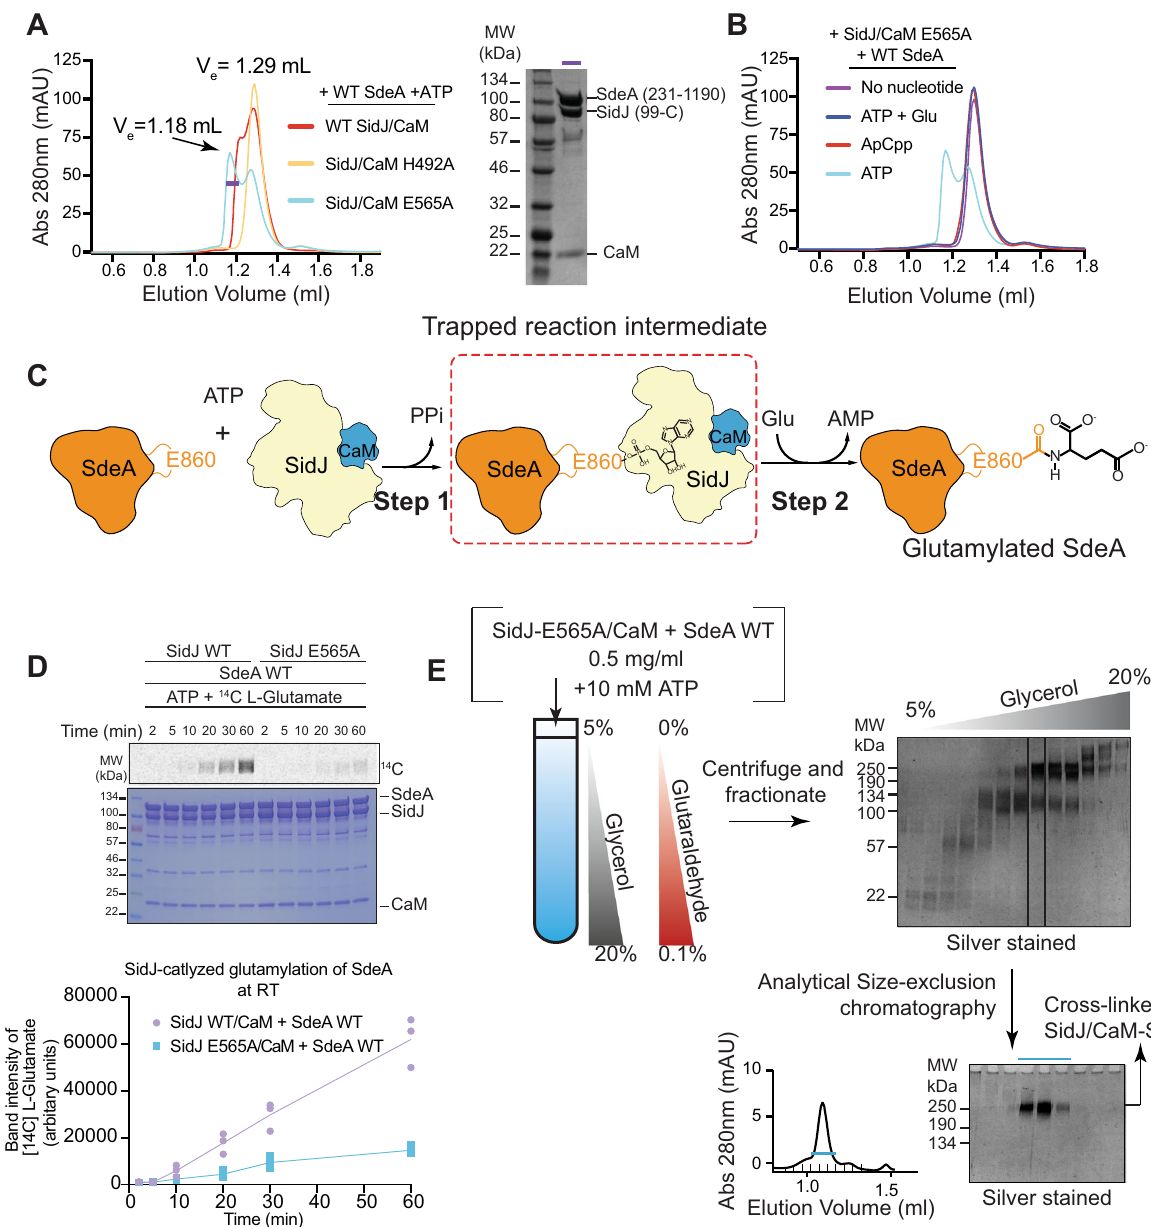
Fig. 1 SidJ E565A/CaM and SdeA form a stable reaction intermediate complex. A Size-exclusion chromatography (SEC) pro fi les of SidJ/CaM and SdeA in the presence of ATP. The highlighted fraction in the SidJ/CaM E565A + SdeA sample is shown on SDS-PAGE (right). B SEC pro fi les of SidJ/CaM E565A + SdeA in the presence of various cofactors. C Schematic representation of the reaction scheme of SidJ-mediate glutamylation of SdeA highlighting the trapped adenylylated reaction intermediate between SidJ/CaM and SdeA. D Time course experiment measuring the incorporation of [ 14 C]-Glu into SdeA catalyzed by SidJ using SidJ WT, SidJ E565A. Samples were separated by SDS-PAGE and visualized by Coomassie stain and autoradiography (Top). The experiment was done in triplicates and [ 14 C]-bands were quanti fi ed and plotted (Bottom). Purple corresponds to WT, blue corresponds to the E565A mutant. Individual measurements are shown. E Flow chart of the sample preparation process of SidJ E565A/CaM + SdeA for Cryo-EM. From left to right, samples are incubated and then cross-linked via GraFix method. Fractions are analyzed via SDS-PAGE and further puri fi ed via SEC. AMP moiety (Fig. 1C). Subsequently, the amino group of a free L - performed at 37 °C. Our time course glutamylation experiment glutamic acid molecule launches a SidJ-enabled nucleophilic performed at room temperature revealed that SidJ E565A is attack on the acyl-AMP intermediate, resulting in glutamylation considerably slower in glutamylating SdeA compared to SidJ WT of the target residue via an isopeptide bond. Our data (Fig. 1A, B) (Fig. 1D). To study this pre-glutamylation complex using cryo- indicates that the SidJ E565A-CaM-SdeA heterotrimeric complex EM, we applied gradient fi xation (GraFix) 23 on the SidJ E565A- CaM-SdeA complex and puri fi ed the cross-linked complex is likely a reaction intermediate that occurs after ATP hydrolysis further using analytical size-exclusion chromatography (Fig. 1E). but before glutamylation by SidJ. Surprisingly, SidJ E565A The puri fi ed SidJ E565A-CaM-SdeA complex elutes in a single glutamylates SdeA to the same extent as WT in our in vitro size-exclusion peak and runs as one cross-linked species in SDS- Fig. 1F) NATURE COMMUNICATIONS| (2021) 12:6174